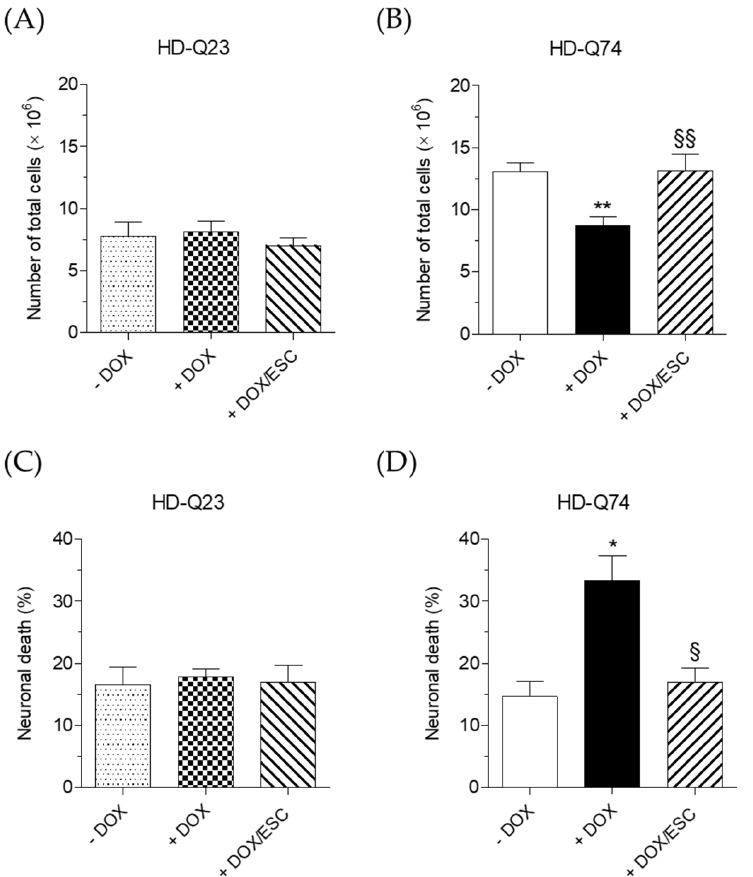
Figure 4. Neuroprotective effects of ESC against mHTT neurotoxicity in HD-Q74 cells. HD-Q23 and HD-Q74 cells were incubated with DOX (1 µ g/mL) for 3 days and ESC (5 µ M) was added during the last 24 h of incubation with DOX. Neurotoxicity, in terms of cytostatic effects ( A , B ) and neuronal death ( C , D ), was assessed using eosin as described in the Materials and Methods. Data are expressed as numbers of total cells and percentages of neuronal death and are reported as the mean ± SEM of at least three independent experiments (* p < 0.05 and ** p < 0.01 vs. HD-Q74 ( − DOX), § p < 0.05 and §§ p < 0.01 vs. HD-Q74 (+DOX) at one-way ANOVA with Bonferroni post hoc test).